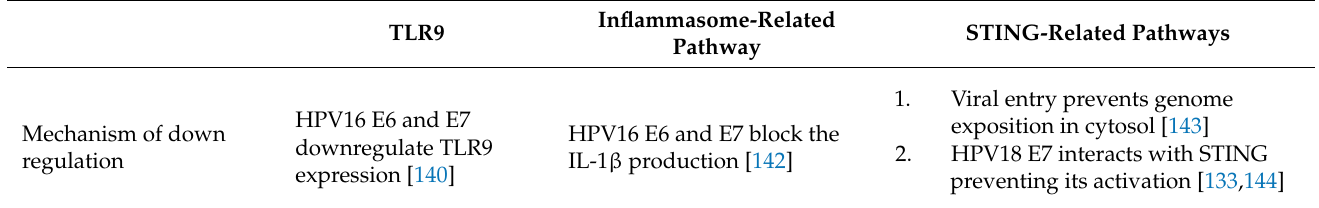
Table 3. Viral proteins and events that lead to the downregulation of the immune sensing of